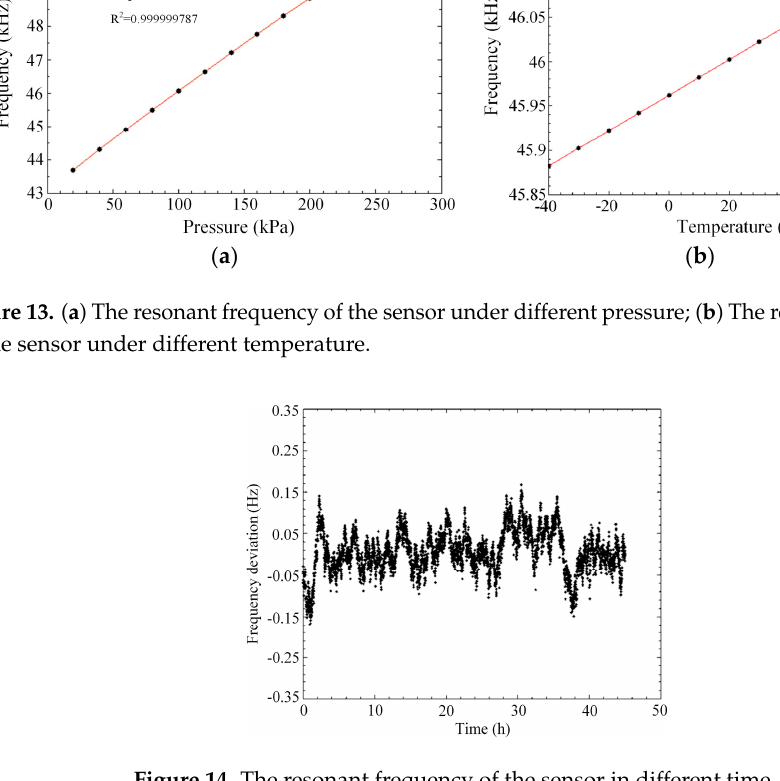
Figure 14. The resonant frequency of the sensor in different